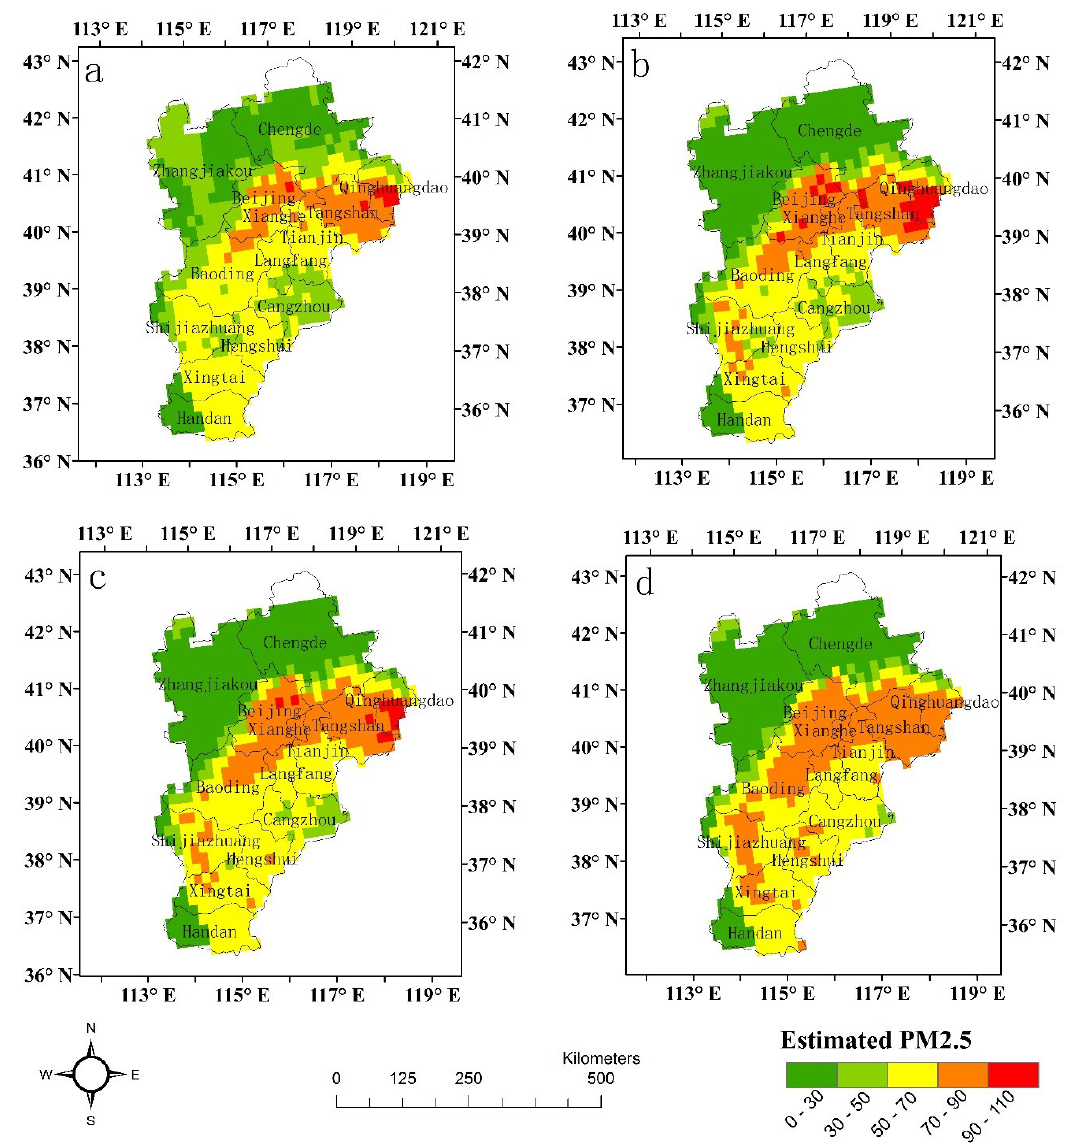
Figure 3. The PM 2.5 spatial distribution based on the four models 2 April 2013) ( a ) the linear regression model; ( b ) the quadratic regression model; ( c ) the power regression model; and ( d ) the logarithmic regression model.